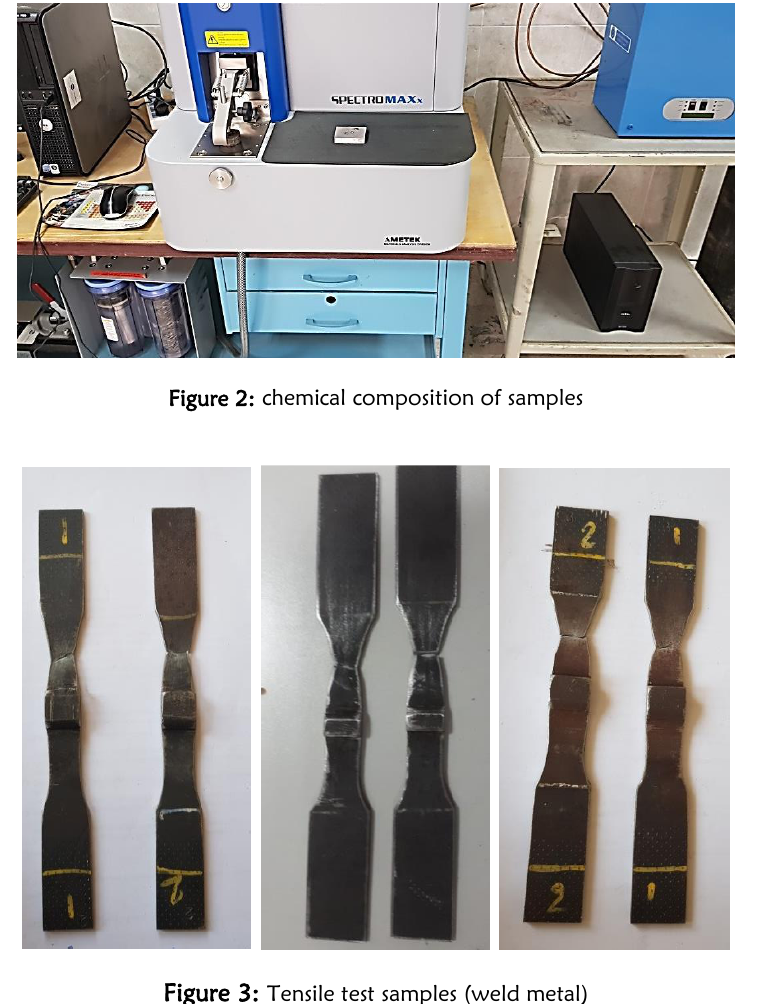
Figure 3: Tensile test samples (weld